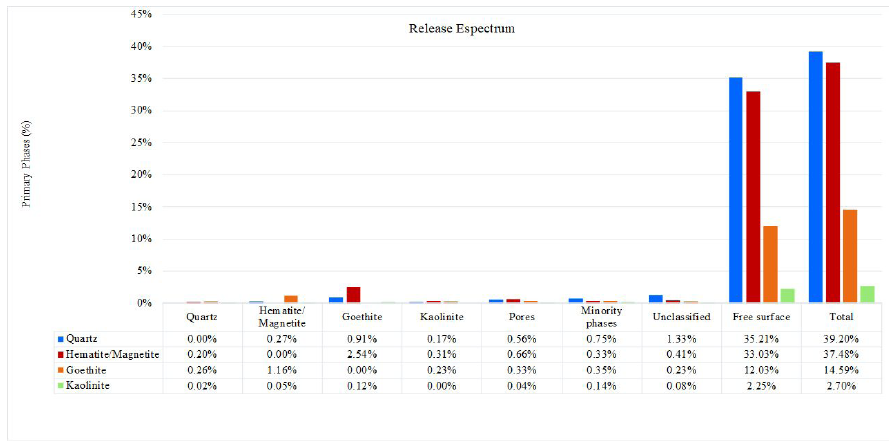
Figure 7. Spectrum of release by primary